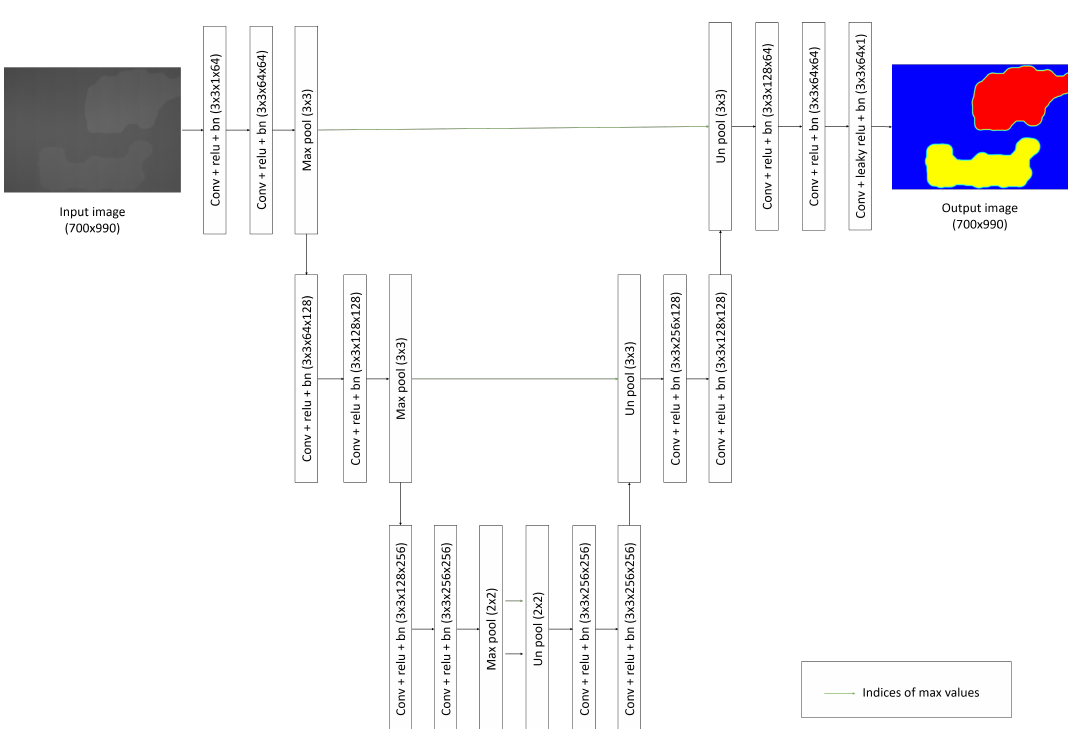
Figure 1. Structure of the network of the proposed